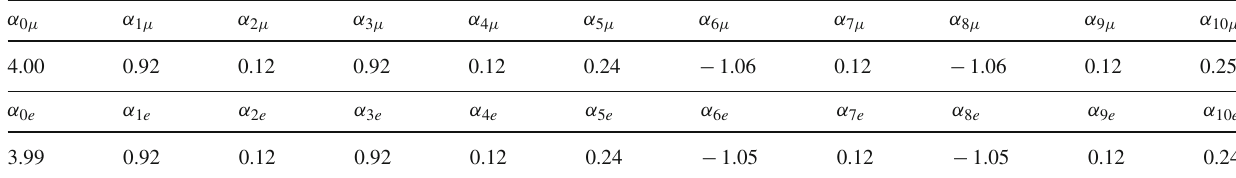
Table 4 Coefficients for the polynomial parameterisation of the numerator and denominator of R [ 1 . 1 , 6 ]